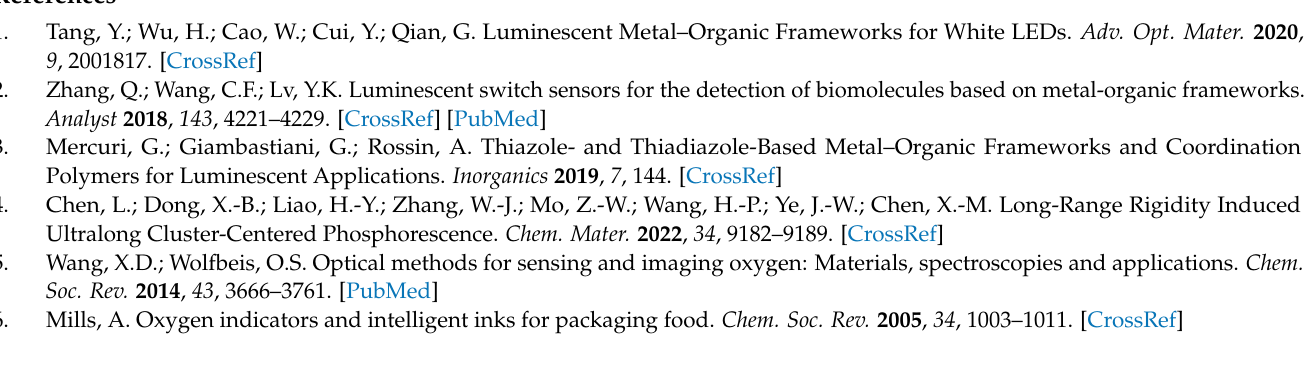
Figure S2: Comparison of the coordination environments of 1 · g (blue) and 1 (green); Figure S3: PXRD patterns of 1 · g and 1 ; Figure S4: Excitation–emission map of 1 ; Figure S5: Emission spectra of 1 · g and 1 —excited at 365 nm; Figure S6: Photographs of 1 (a) in 1 bar O 2 , (b) air, and (c) a vacuum—excited by 365 nm UV light; Figure S7: The emission spectra of 1 · g in air and 1 atm O 2 ; Figure S8: Under the excitation of 365 nm, (a) the emission spectra of 1 · g in the temperature range from 80 to 300 K with an interval of 20 K and (b) the integral intensities of 1 · g at different temperatures. Table S1: Elemental analysis results for 1 ; Table S2: Crystallographic data and structural refinements of 1 · g and 1 ; Table S3: Decay curves of 1 in 1 bar O 2 , air, and a vacuum—excited by 375 nm VPL and detected at 542